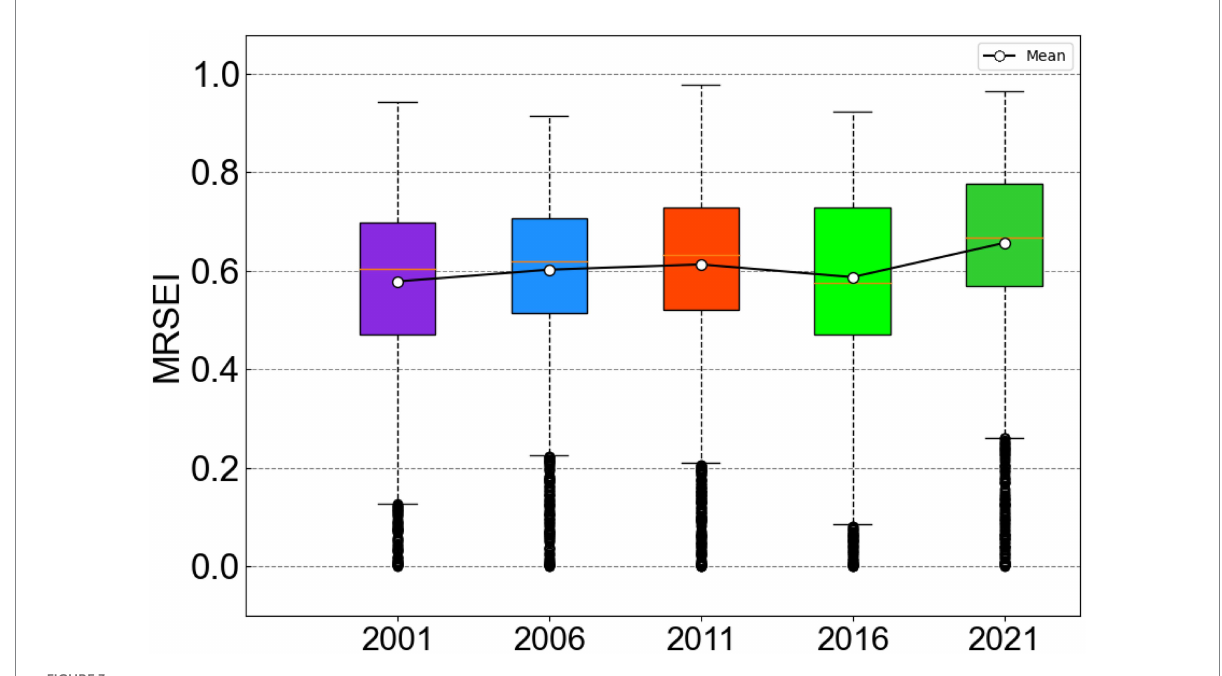
FIGURE 3 MRSEI Data Box diagram of study area from 2001 to